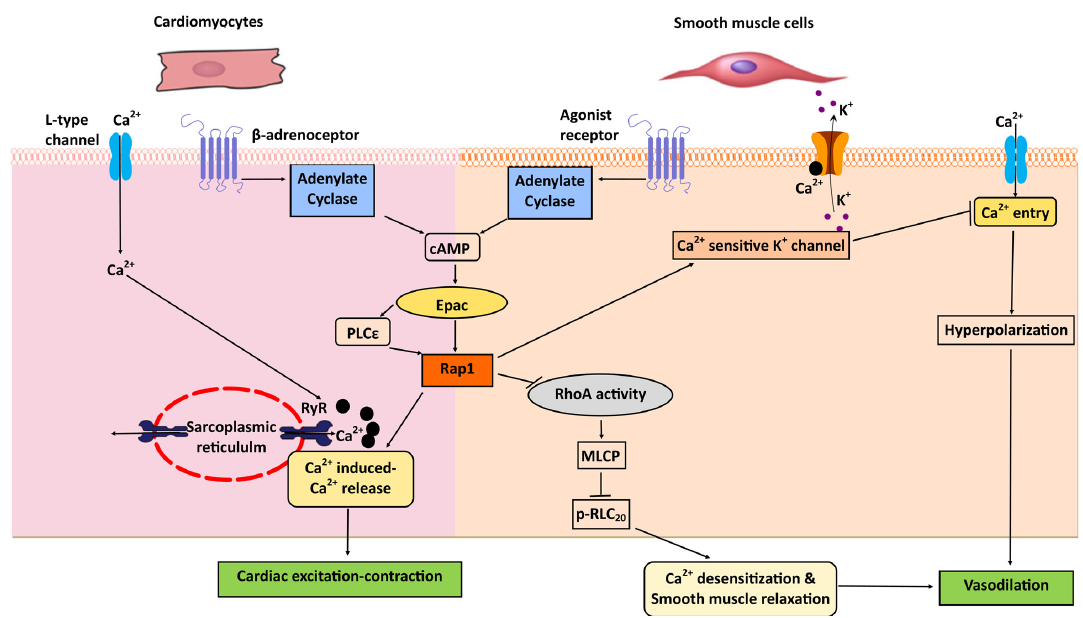
Figure 4. Rap1 and Ca 2+ signaling in cardiac and smooth muscle function. In cardiomyocytes, cAMP/Epac-activated Rap1 stimulates Ca 2+ -induced Ca 2+ release (CICR) from sarcoplasmic reticulum stores through ryanodine receptors (RyR) to regulate excitation–contraction coupling. In smooth muscle cells, Rap1 inhibits RhoA activity and relieves the disinhibition of myosin light-chain phosphatase (MLCP), which decreases myosin regulatory light chain of myosin (RLC 20 ) phosphorylation,